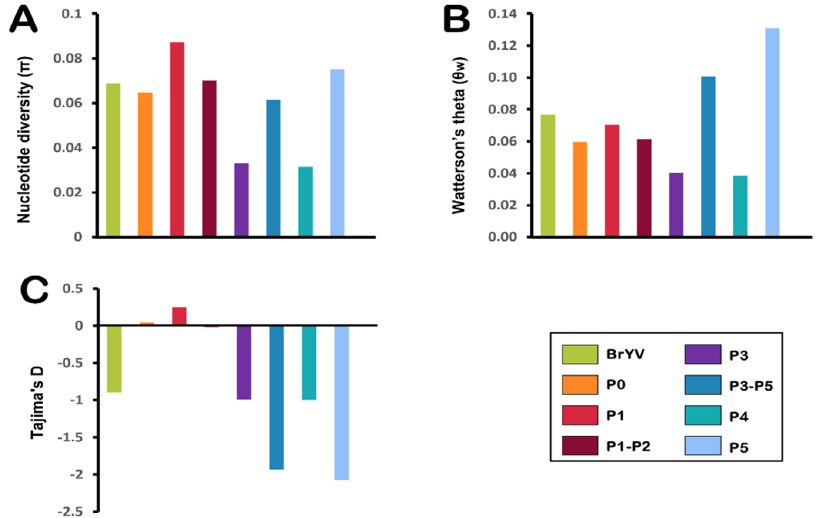
Figure 4. Estimation of genetic diversity was performed for the BrYV genome and individual genes. The calculated population genetic parameters include ( A ) nucleotide diversity ( π ), ( B ) Watterson’s theta ( θ w ), and ( C ) Tajima’s D . Table 3. Molecular diversity among BrYV populations and individual genes.